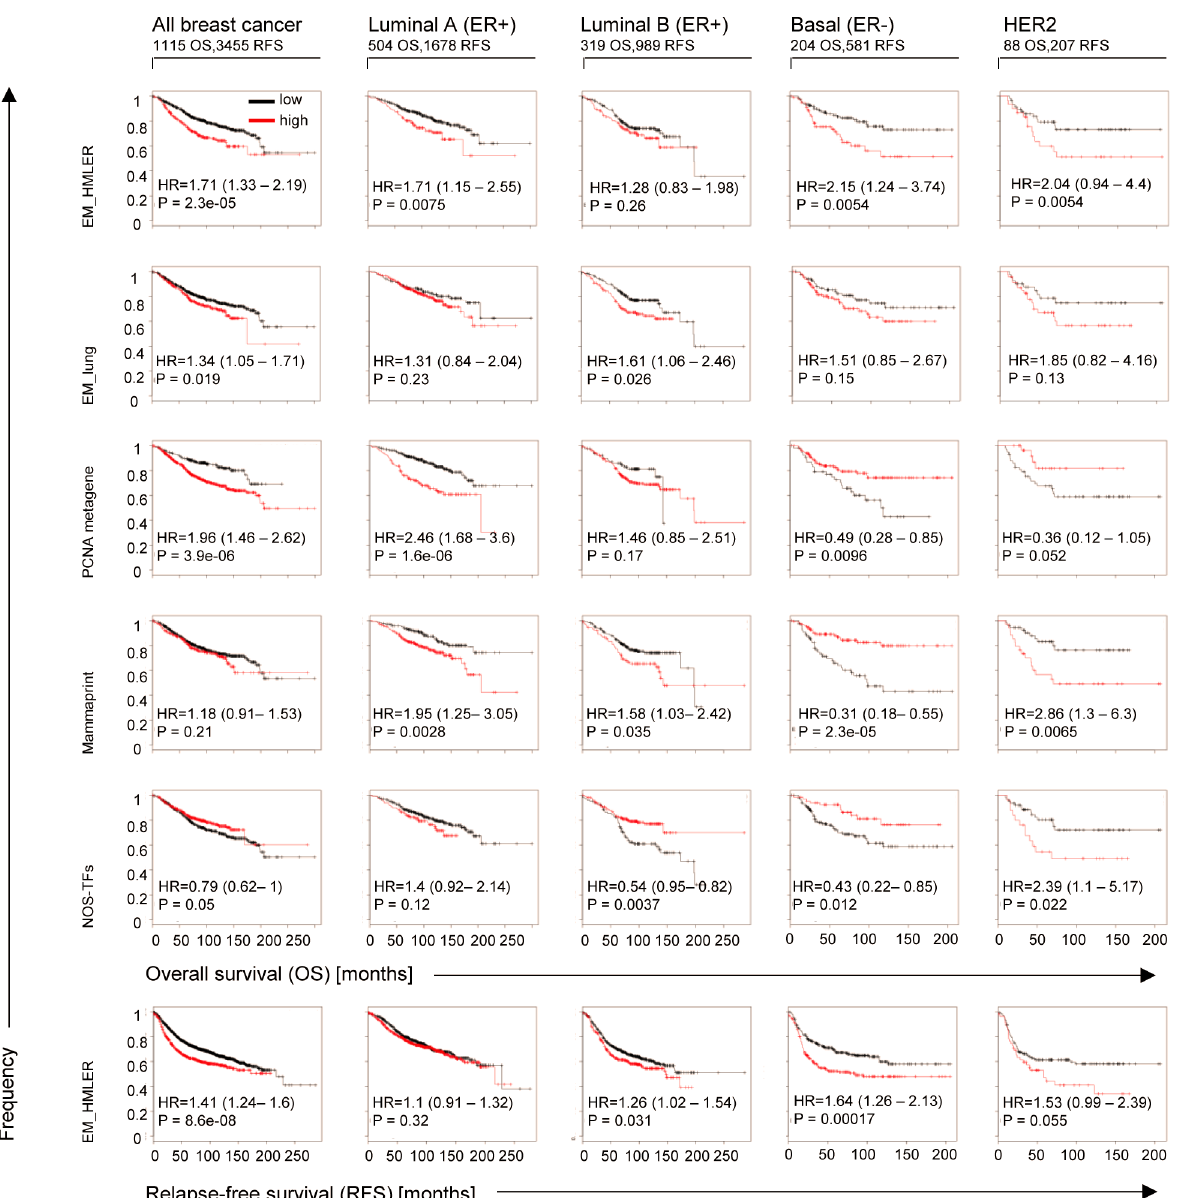
Fig 2. Co-expression of E and M genes predicts poor breast cancer patient survival. Kaplan-Meier plots showing time of overall survival (OS) and relapse-free survival (RFS) of breast cancer patients with different intrinsic breast cancer subtypes using the indicated gene expression signatures consisting of 60 genes (S2 Table) and the Kaplan-Meier-Plotter online tool (database 2014). Numbers of patients within tumor subtype for OS or RFS are indicated on top. Hazard ratio (HR) and respective logrank p-values (P) that discriminate high (red line) and low (black line) expressing patient groups are